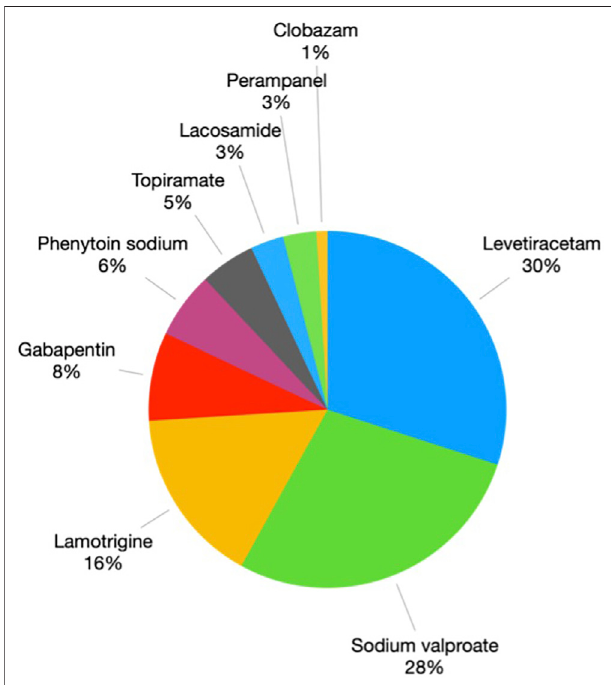
FIGURE 3 | Alternative drugs were prescribed in patients with HLA- B*15:02